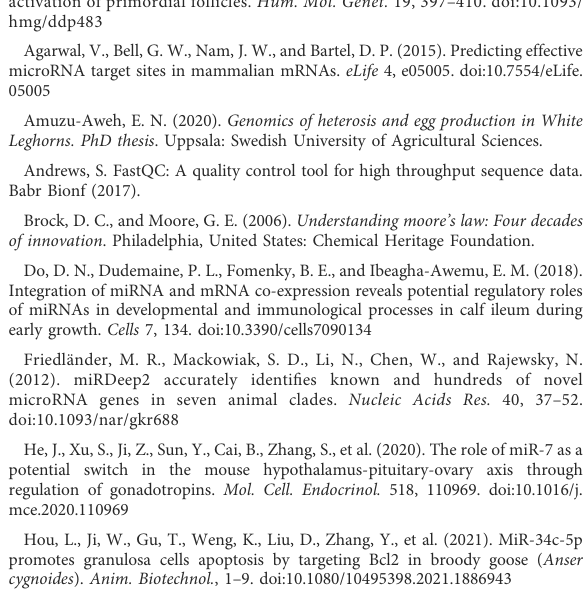
SUPPLEMENTARY FIGURE S1 Mapping statistics for the 16 miRNA libraries in parental purebred lines and their reciprocal hybrids. SUPPLEMENTARY FIGURE S2 Venn diagram depicting number of DEMiRs with additive mode of expression. SUPPLEMENTARY TABLE S1 RNA-seq reads mapped to non-coding regions other than miRNAs expressed in the pre-hierarchical follicles of purebred chicken parental lines (R and W) and their reciprocal hybrids (RW and WR). SUPPLEMENTARY TABLE S2 Expressed miRNAs in the pre-hierarchical follicles of purebred chicken parental lines (R and W) and their reciprocal hybrids (RW and WR). SUPPLEMENTARY TABLE S3 Mode of expression of novel miRNAs in the pre-hierarchical follicles of purebred chicken parental lines (R and W) and their reciprocal hybrids (RW and